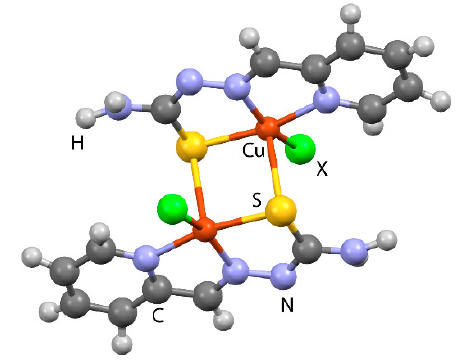
Figure 1. [{CuLX} 2 ] complex